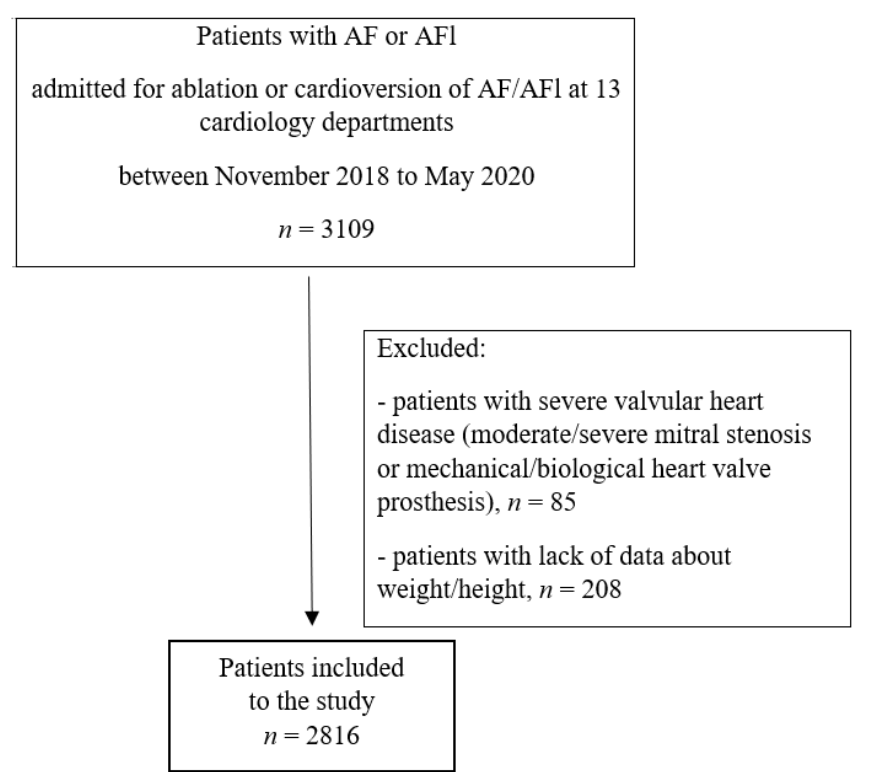
Figure 1. The flowchart of the study. Abbreviations: AF, atrial fibrillation; AFl, atrial flutter.